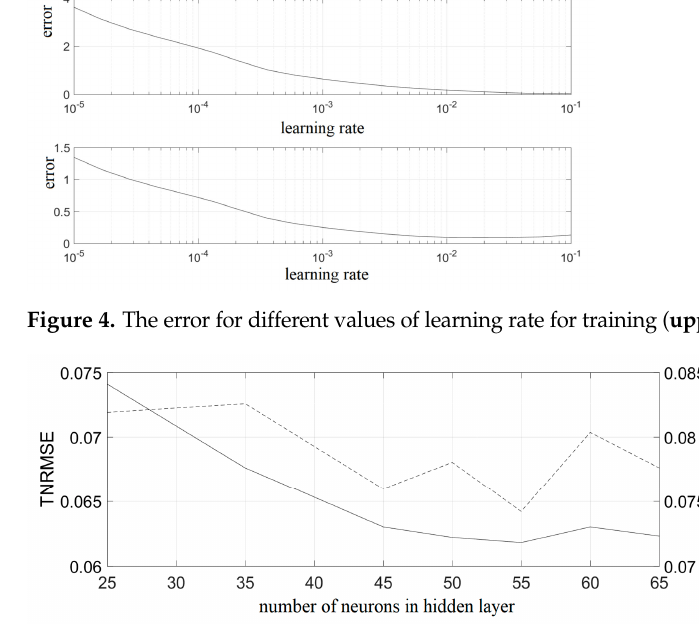
Figure 5. TNRMSE ( solid line ) and VNRMSE ( dashed line ) for different ANN